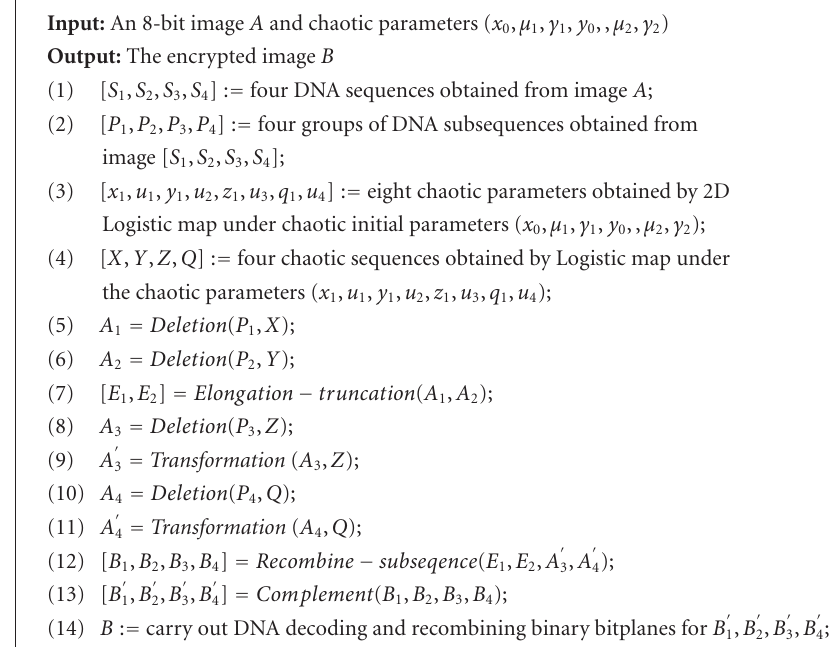
Algorithm 1: An image encryption algorithm based on DNA subsequence operation.